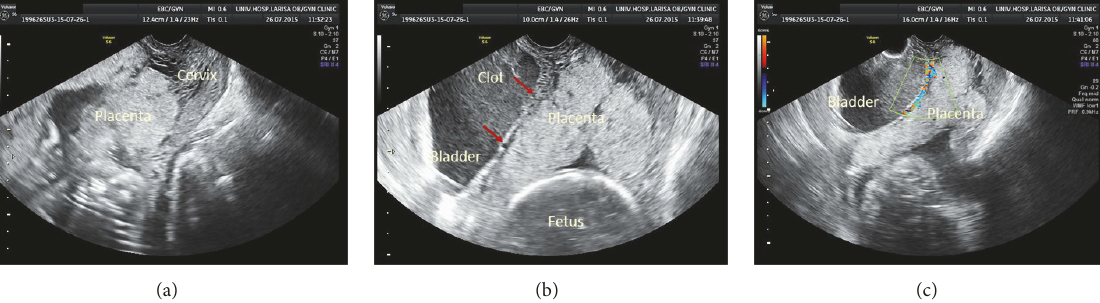
Figure 1: (a) Complete placenta previa. (b) Disruption of the bladder-placental interface indicated by red arrows. (c) Color Doppler revealed hypervascularity between the placenta and the